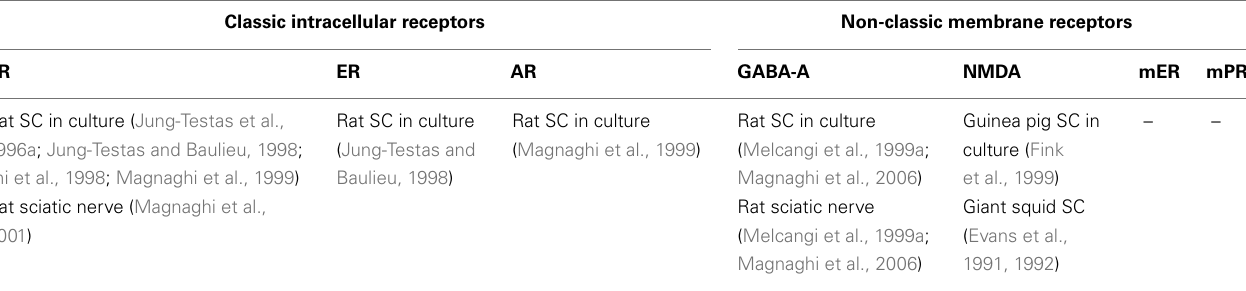
Table 3 | Distribution of major classic and non-classic receptors for neurosteroids in Schwann